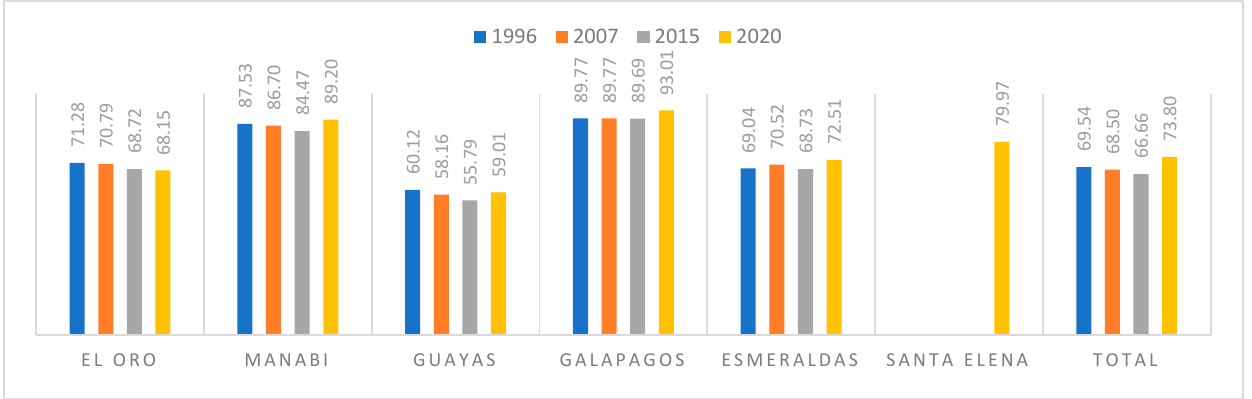
Figure 4. Reticular fragmentation index changes of mangrove forests in the years 1996, 2007, 2015, and 2020 by province.